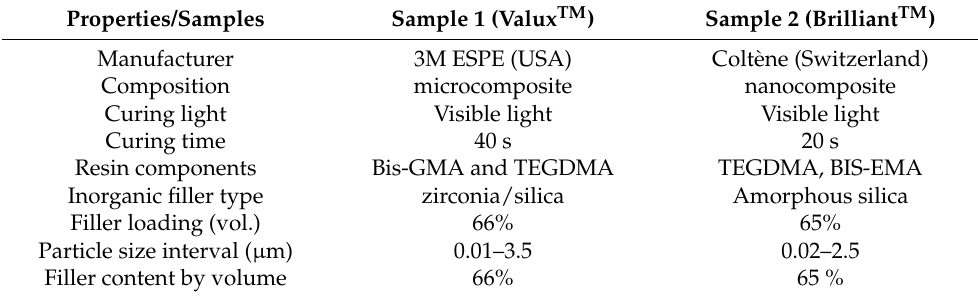
Table 1. Characteristics of the two samples investigated in the present